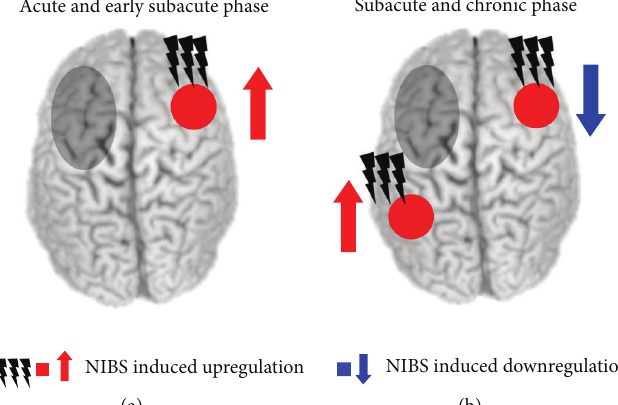
Figure 3: Illustration of a phase-specific stimulation approach to promote language recovery after left-hemispheric stroke. Note that the appropriate stimulation protocol might strongly depend on the site and size of the lesion and the individual deficits. (a) In the acute and early subacute phase, an upregulation of homologous right-hemispheric regions with facilitatory noninvasive brain stimulation (NIBS) might promote language recovery. (b) In the late subacute and chronic phase, patients might rather benefit from an inhibition of homologous right-hemispheric regions and an upregulation of ipsilesional regions by NIBS. Grey circles illustrate a stroke-induced